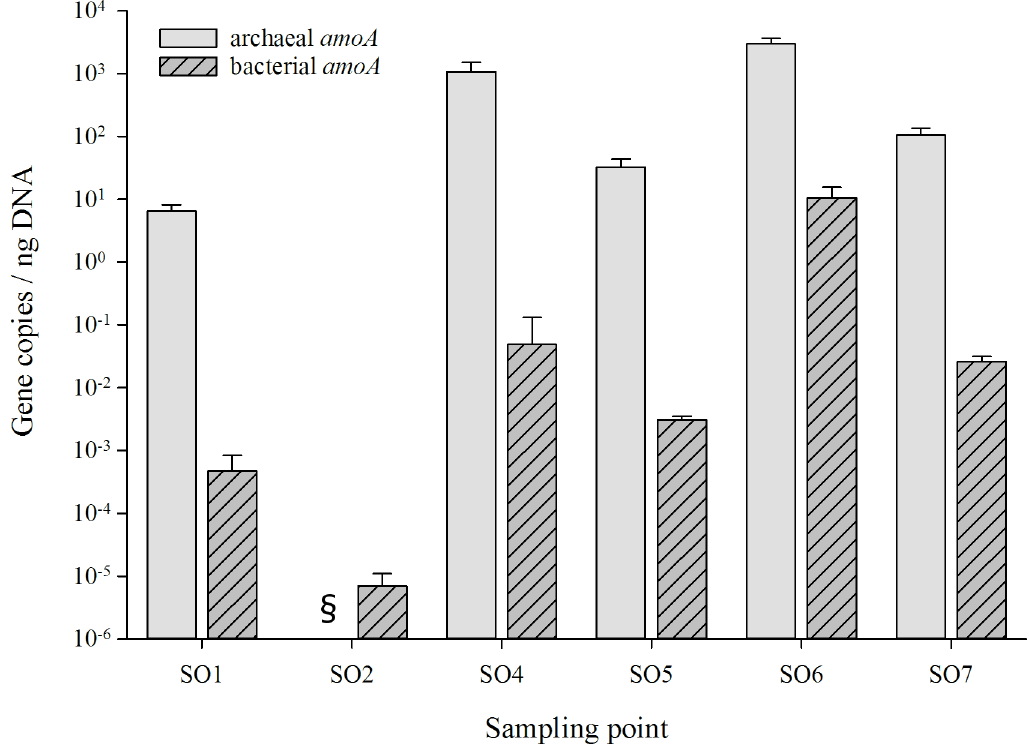
Fig 7. Abundance of the bacterial and archaeal amoA genes. § indicatesthat no amplification was observedat this samplingpoint for archaeal amoA genes. SO3 was not investigateddue to the lack of DNA. Standarddeviationis given as Error Bars (n =